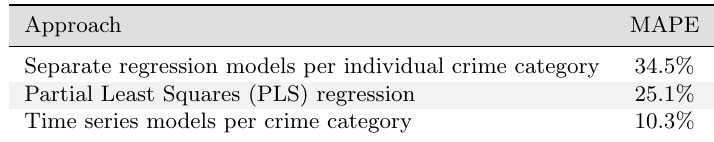
Table 1: Comparative values of MAPE for the three forecasting